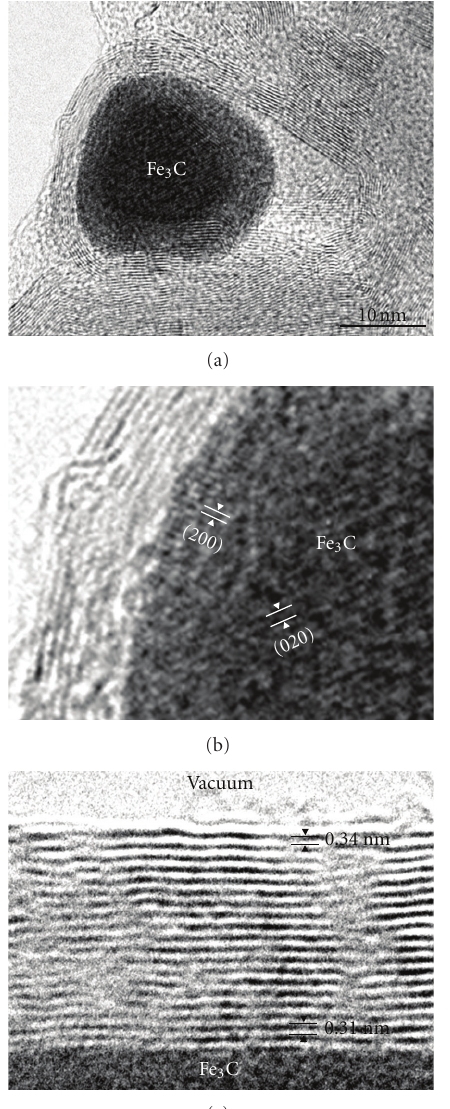
Figure 6: (a) High-resolution images of Fe 3 C-encapsulated carbon nanocapsule and (b) enlargement of the (200) and (020) lattice fringes of the Fe 3 C particle in (a). (c) Graphene layers of the carbon nanocapsule in (a).